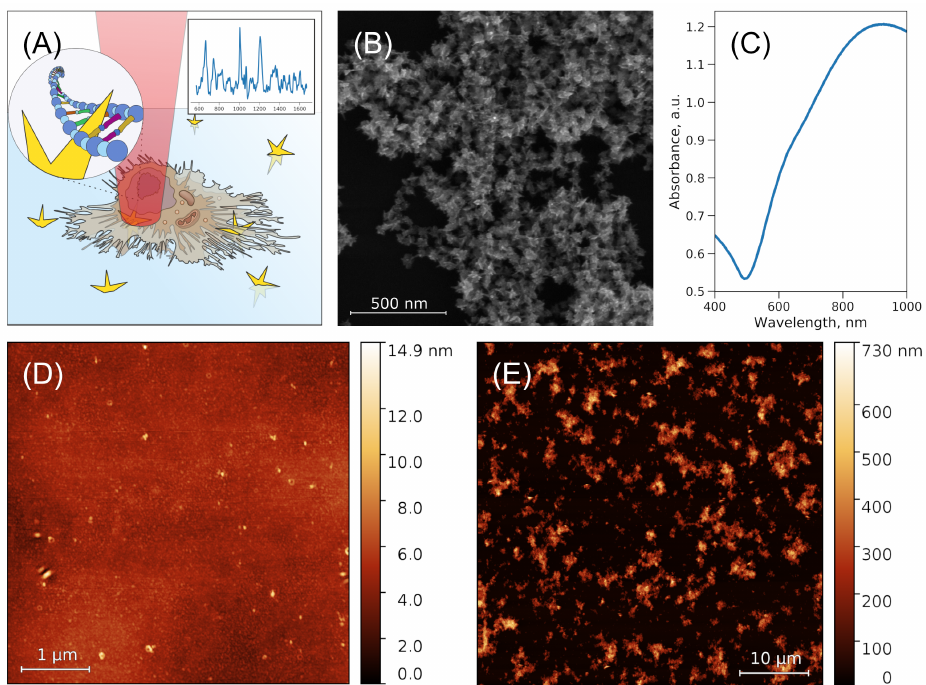
Figure 1. ( A ) Experimental scheme: a cell is attached to a nanostructured surface consisting of gold nanostars deposited on a PVPyr layer on a coverslip. ( B ) SEM image of nanostructured surface. ( C ) Absorption spectra of a freshly synthesized suspension of gold nanostars. ( D ) AFM image of the PVPyr layer and ( E ) PVPyr layer with Au